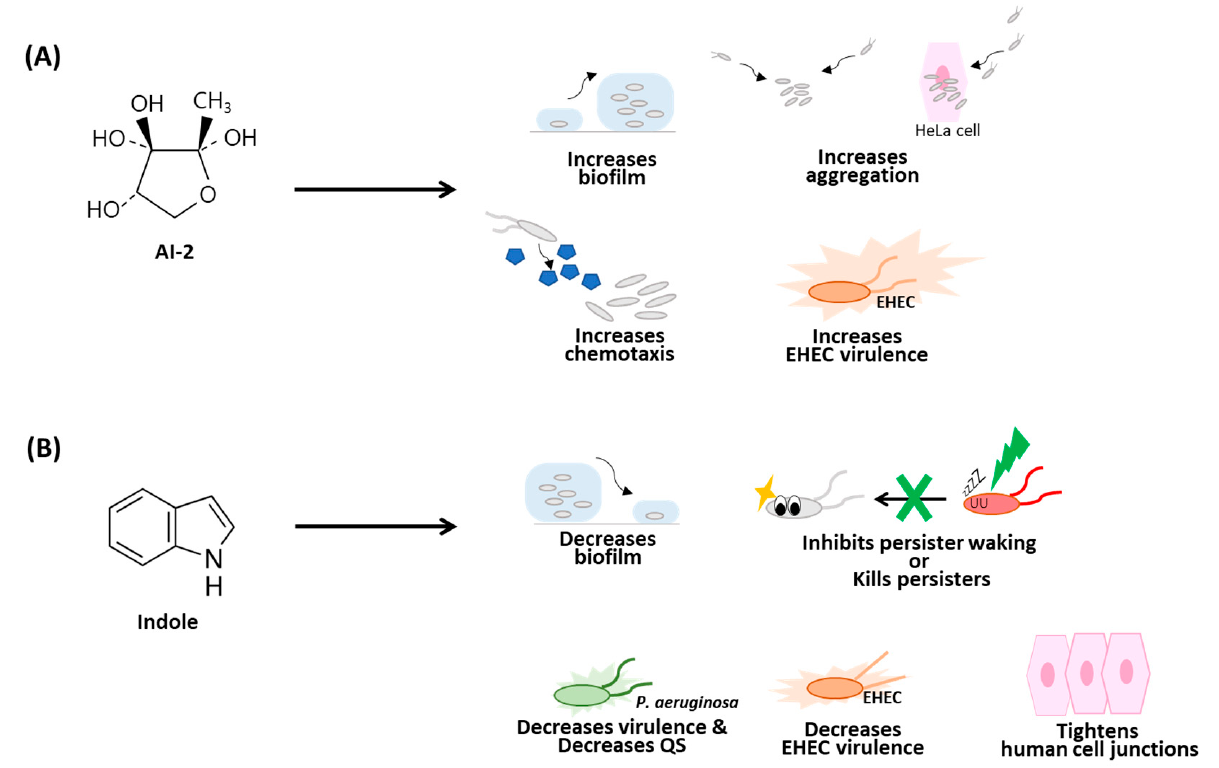
Figure 1. Comparison of the phenotypes affected by ( A ) autoinducer 2 (AI-2) and ( B ) indole. Curved black arrows indicate cell motility/movement, QS is quorum sensing, EHEC is Escherichia coli O157:H7, and flagella are indicated by two lines at one of the cell poles. Human cells are indicated by pink hexagons. Green lightning indicates the application of indole. The R -2-methyl-2,3,3,4-tetrahydroxytetrahydrofuran ( R -THMF) form of AI-2 is shown.